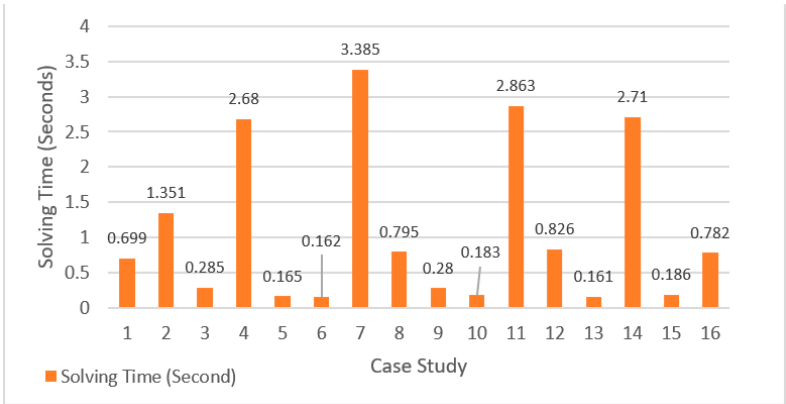
Figure 23. The results of solving time for the studied cases.